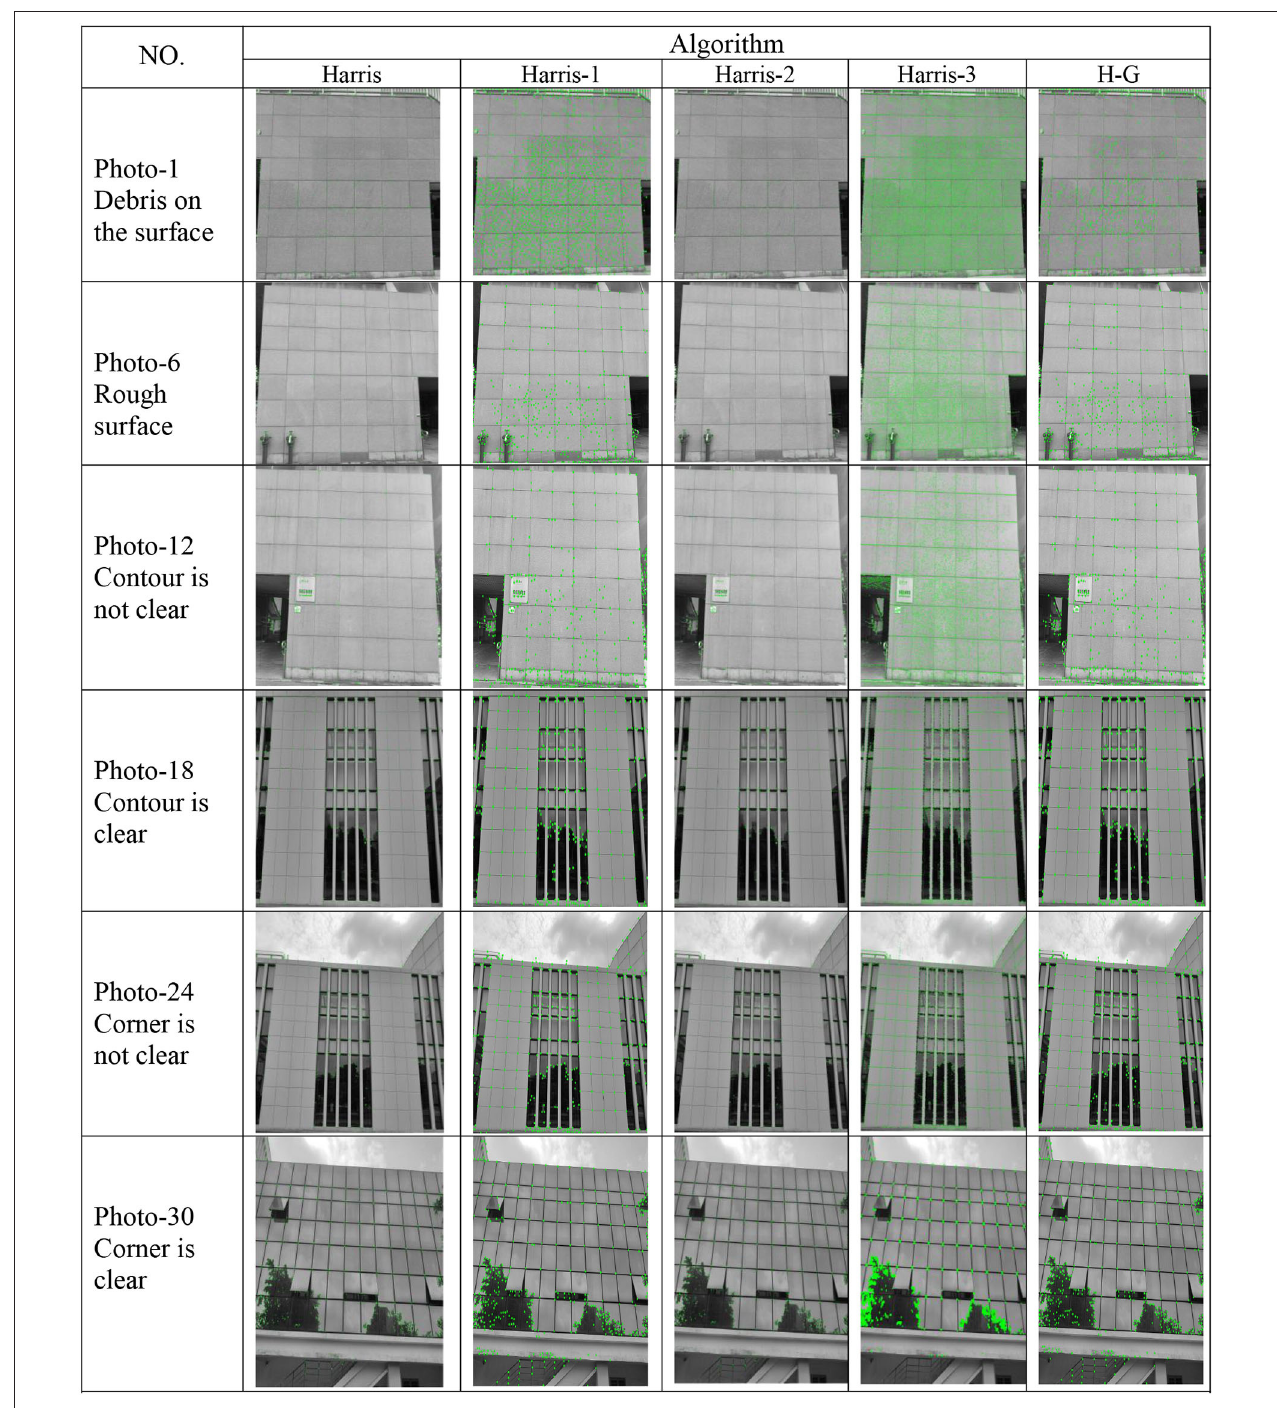
FIGURE 8 | Result of representative photo–class